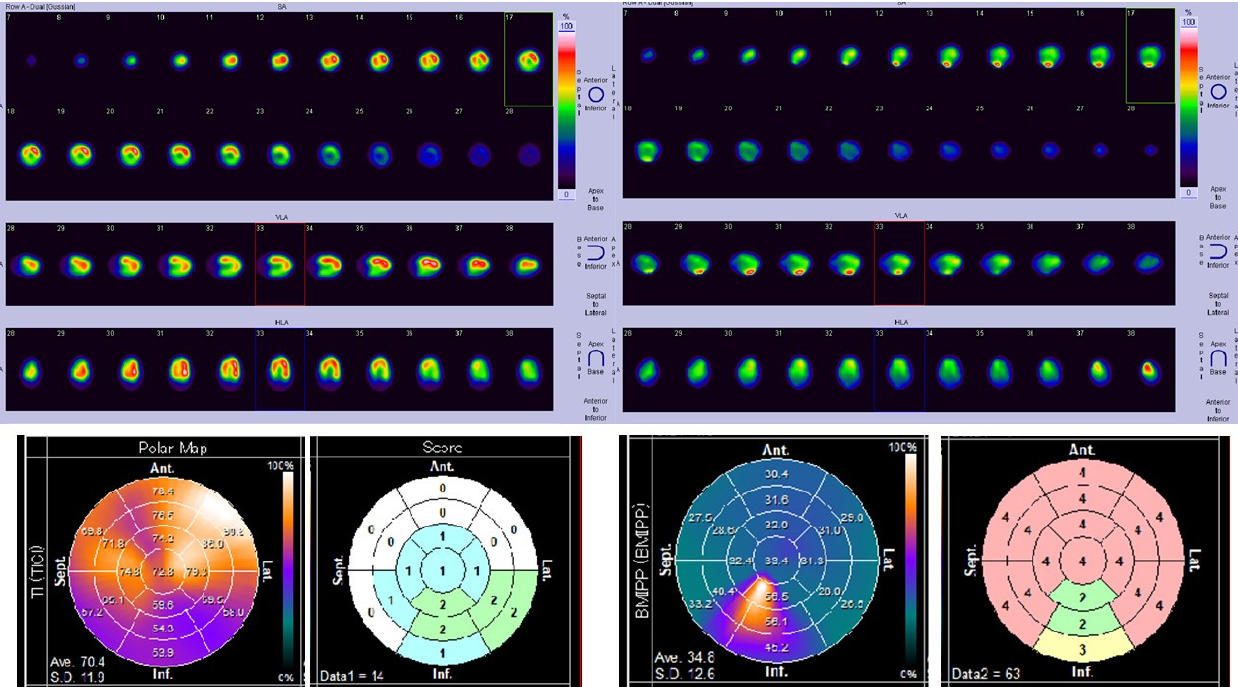
Figure 3. SPECT images, polar maps, and Heart Risk View-S scores for Case G. Left top: SPECT images of 201 Tl perfusion scintigraphy. Left bottom: polar map and scores of 201 Tl. Right top: SPECT images of 123 I-BMIPP metabolism scintigraphy. Right bottom: polar map and scores of 123 I-BMIPP. The total Heart Risk View-S scores of 201 Tl and 123 I-BMIPP scintigraphy for CTRCD patients are shown in Table 3. Table 3. Patients diagnosed with CTRCD.